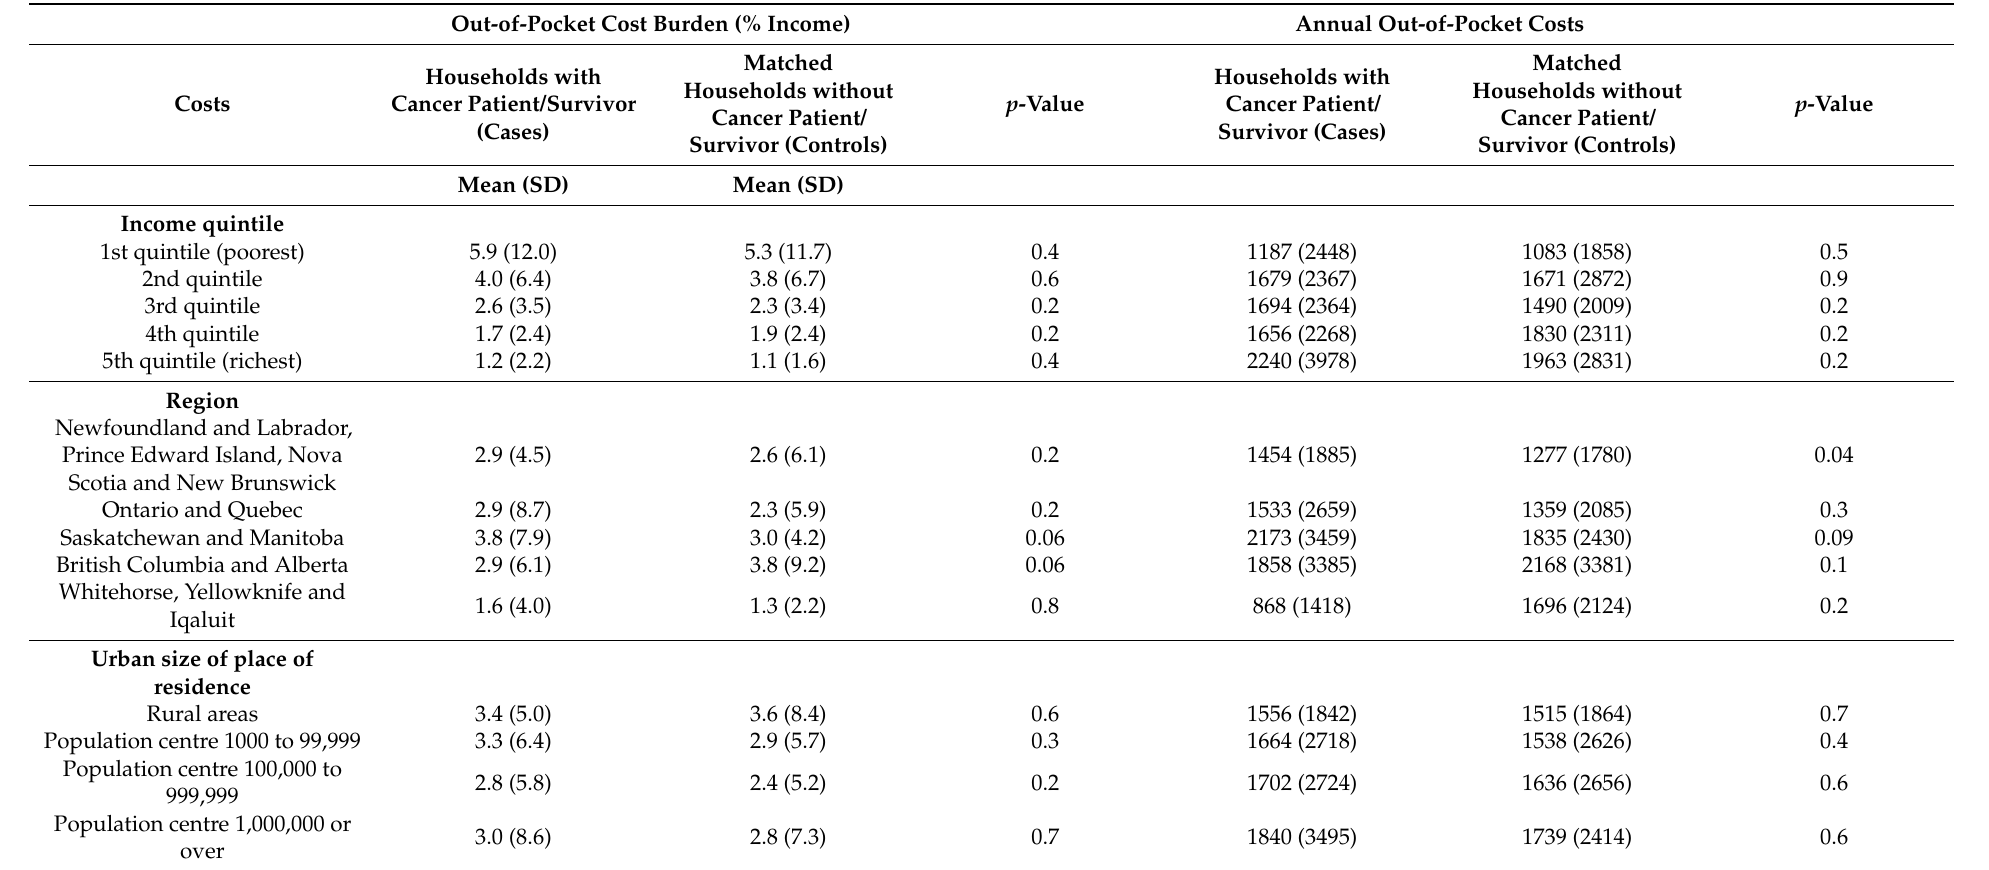
Table 3. Summary of out-of-pocket cost burden and out-of-pocket expenditures by household characteristics and cancer type (cases-only). Out-of-Pocket Cost Burden (%